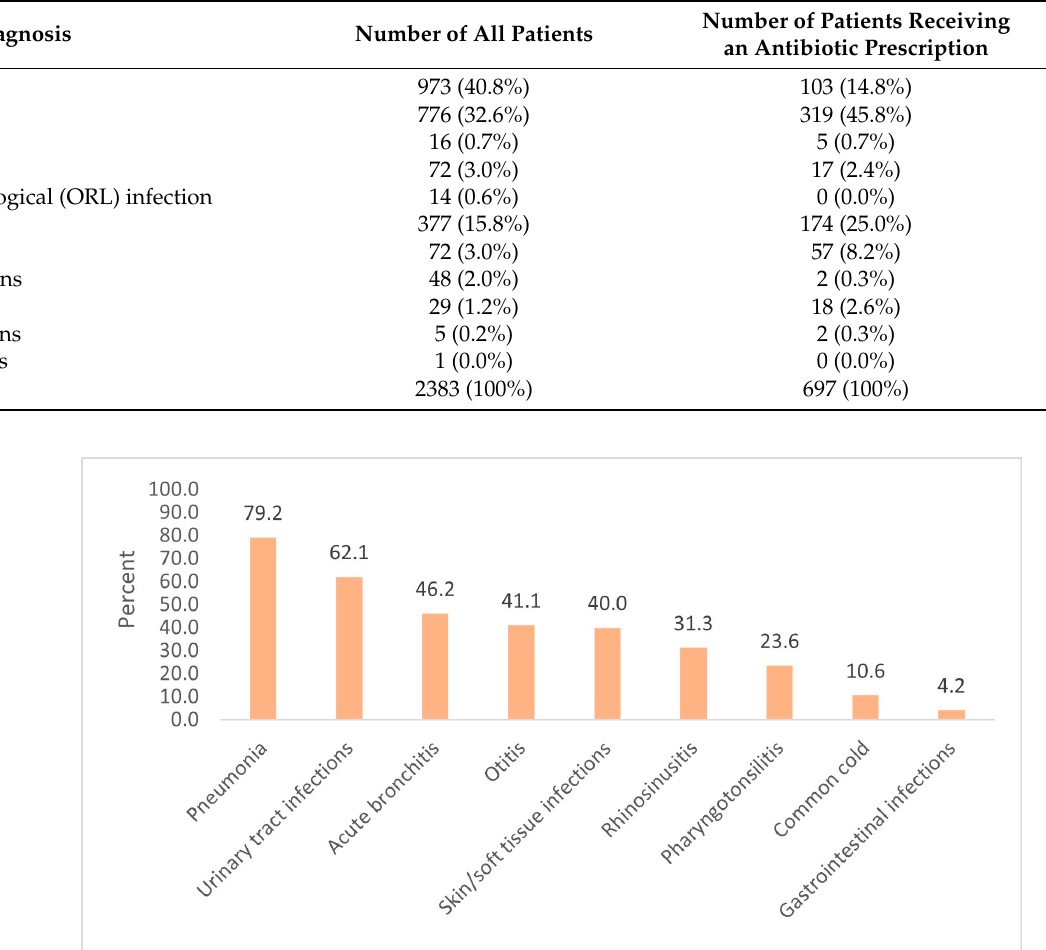
Figure 2. The proportion of patients (%) treated with antibiotics for each type of infection.